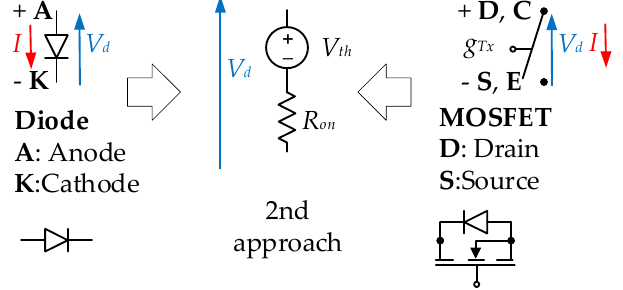
Figure 4. Analysis of implementation of the second approach in a diode and a MOSFET configuration. Five different variants have been developed to calculate the inverter’s conduction voltage drop (Figure 5): the ideal output voltage; on-resistance ( R on ) and threshold voltage ( V th ) dependent voltage drop; junction temperature ( T j ) dependent voltage drop; current dependent voltage drop; and current and T j dependent voltage drop.